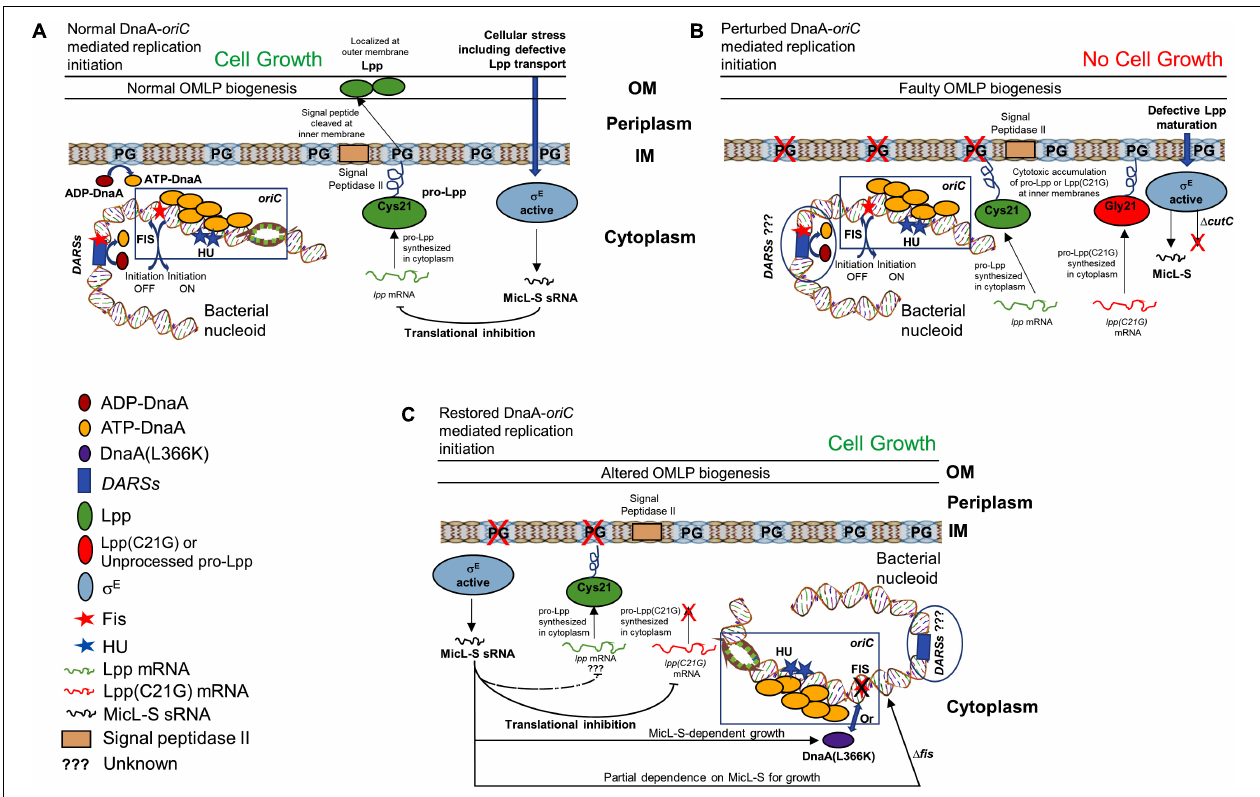
FIGURE 10 | Schematic representation of how membrane stress caused by unprocessed outer membrane lipoprotein intermediate pro-Lpp affects DnaA and Fis-dependent growth. (A) Cells carrying normal cellular levels of inner membrane acidic phospholipids, PG, and CL support biogenesis of outer membrane lipoprotein (Lpp) and initiate DNA replication at the chromosomal origins. ATP-DnaA binds at specific oriC sites, and in the presence of HU protein, unwinds the duplex DNA, leading to the formation of a functional replisome. Acidic membranes and the specific chromosomal site DARSs play a role in the rejuvenation of replication-defective ADP-DnaA to replication-proficient ATP-DnaA. Binding of Fis protein at oriC and DARSs helps maintain timely inhibition of replication initiation. Stress to the cellular envelope stimulates the activation of an alternative sigma factor (such as sigma factor E, σ E ), which regulates the production of Lpp protein through MicL-S sRNA in response to the defective Lpp localization. (B) Cells unable to synthesize PG or that accumulate cytotoxic mutant Lpp(C21G) on the inner membrane are negatively affected for growth. (C) Cells expressing Lpp(C21G) or lacking PG can grow in a σ E -dependent MicL-S sRNA manner, when overexpressing DnaA(L366K). In addition, restoration of growth can occur in cells lacking fis , independently of MicL-S